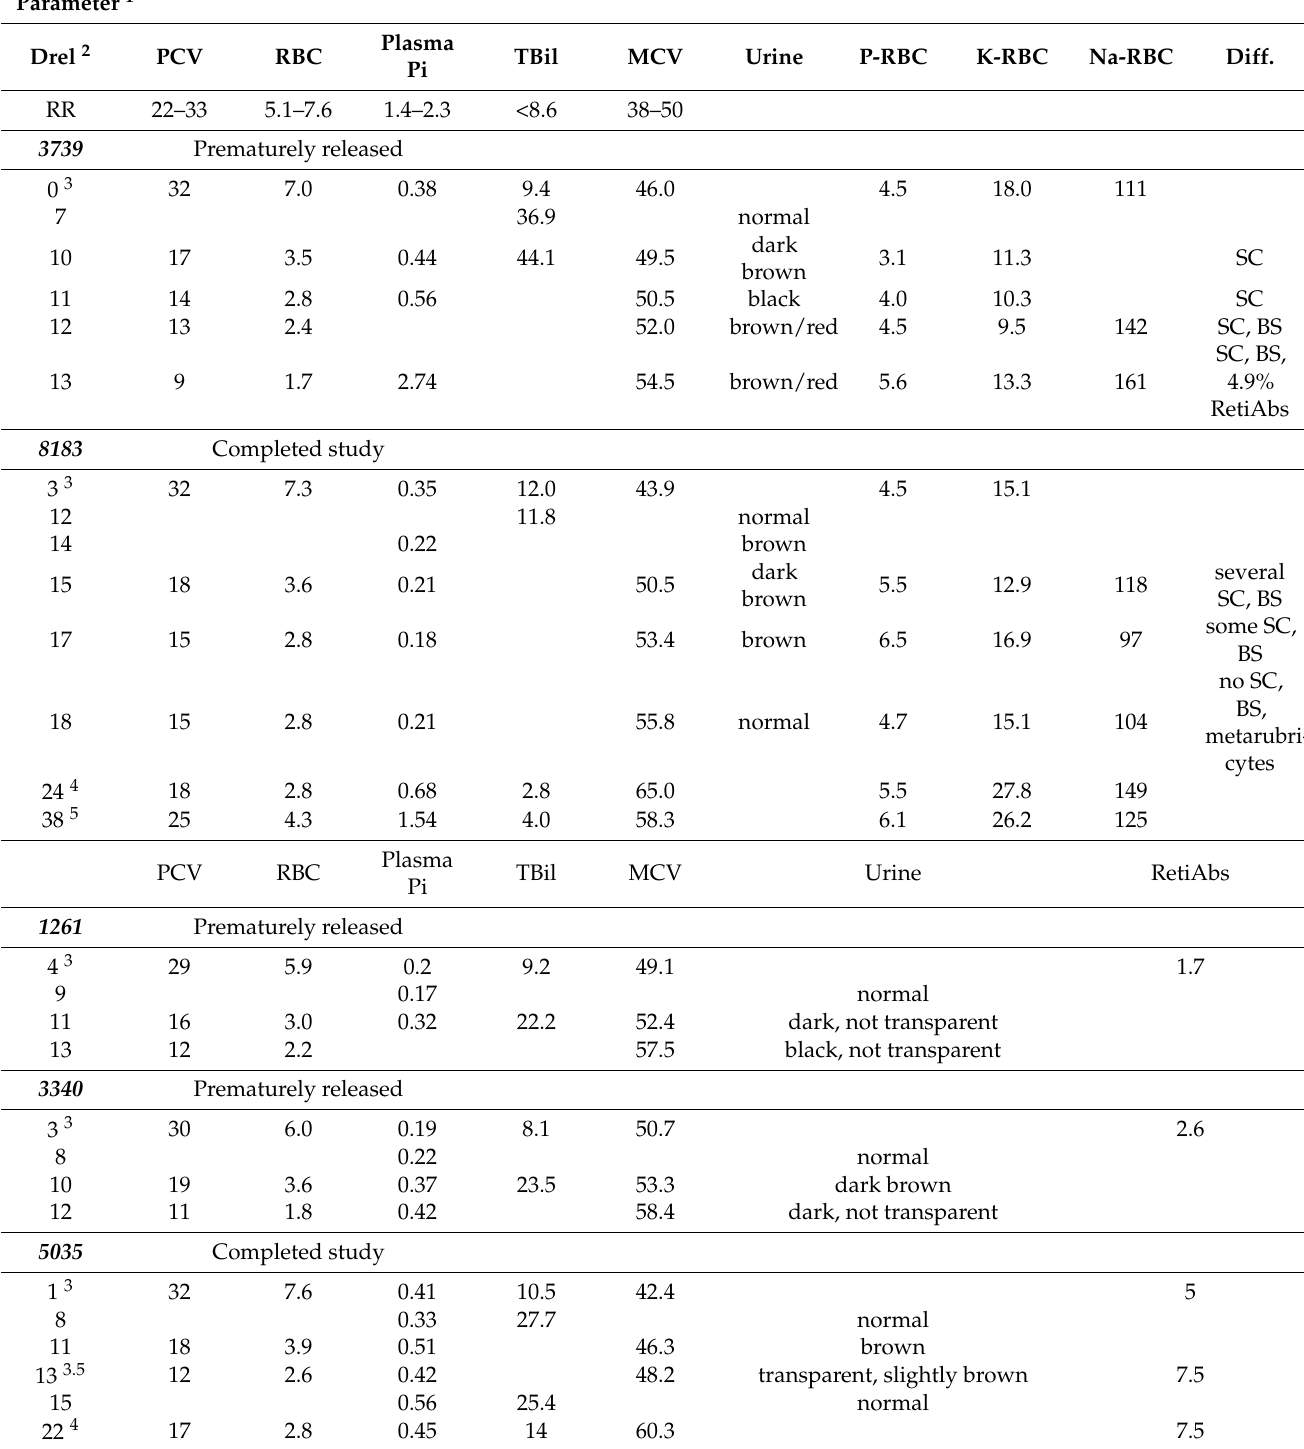
Table 1. Several parameters of LP-PPH2 cows after parturition.